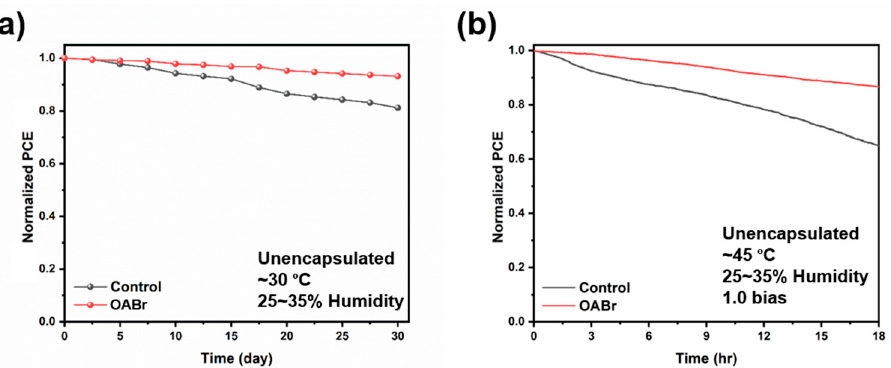
Figure 4. ( a ) Storage stability test for control and OABr-treated CsPbBr 3 PPVs. Devices were kept in air condition without encapsulation. ( b ) Maximum power point tracking measurement. Devices were measured under 1.0 V bias and AM 1.5 G illumination (100 mW cm − 2 ).